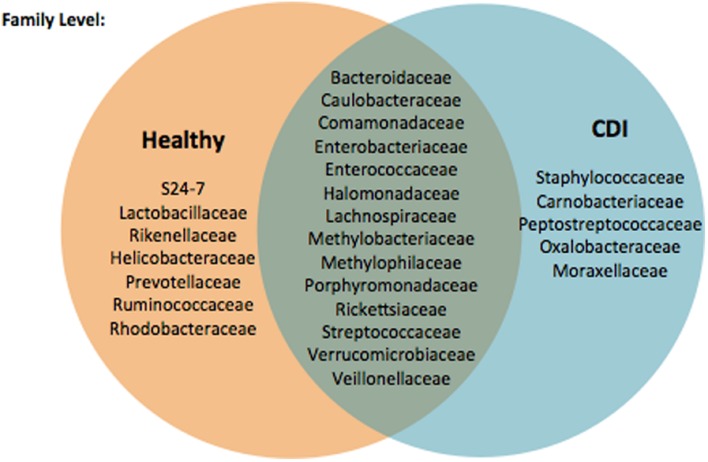
Venn diagram demonstrating distinct and shared OTUs between non-CDI and CDI states.